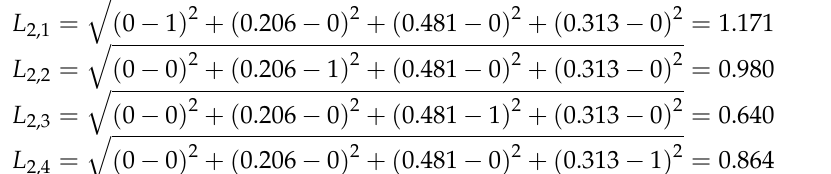
According to Equation (26), when p = 1, sample 1 could be calculated using the distance discriminant method to predict rockburst class III, which belongs to the medium rockburst